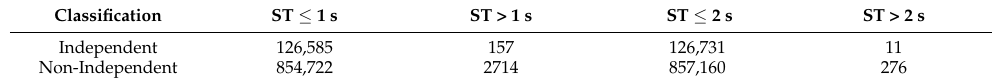
Table 17. ST exceeds 1:2